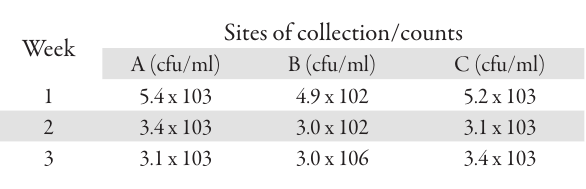
Tab. 2. Fungal profile of Sugarcane Bagasse dumping site